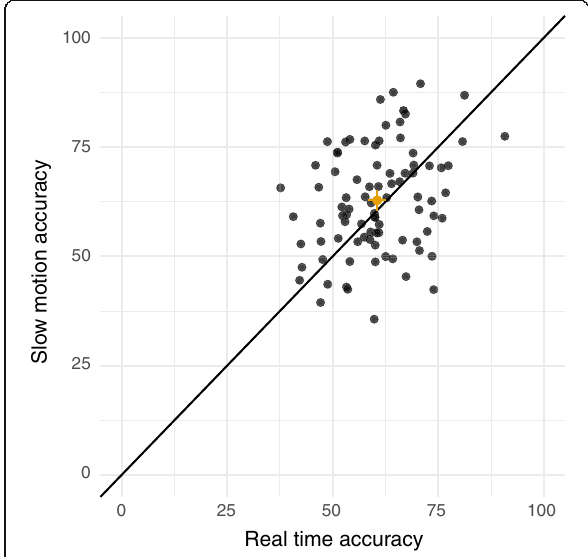
Fig. 2 Scatterplot of the individual accuracy data in percentage. The accuracy for the slow-motion condition is plotted against the accuracy for the real-time condition. Dots indicate individual referees and the solid line indicates the identity line. The orange dot indicates the mean accuracy across referees. The orange lines indicate bootstrapped 95% confidence intervals for the mean accuracy in both conditions